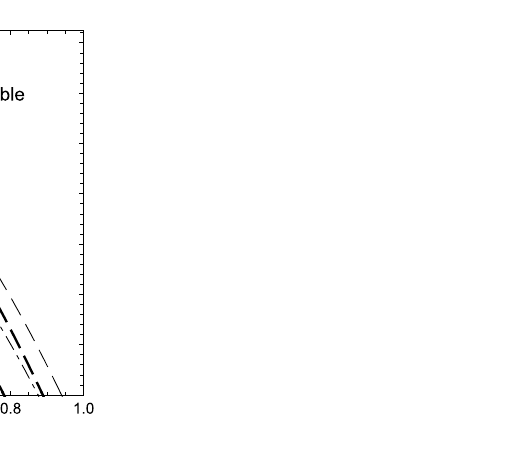
0 (thin lines) and 3/4 (thick =